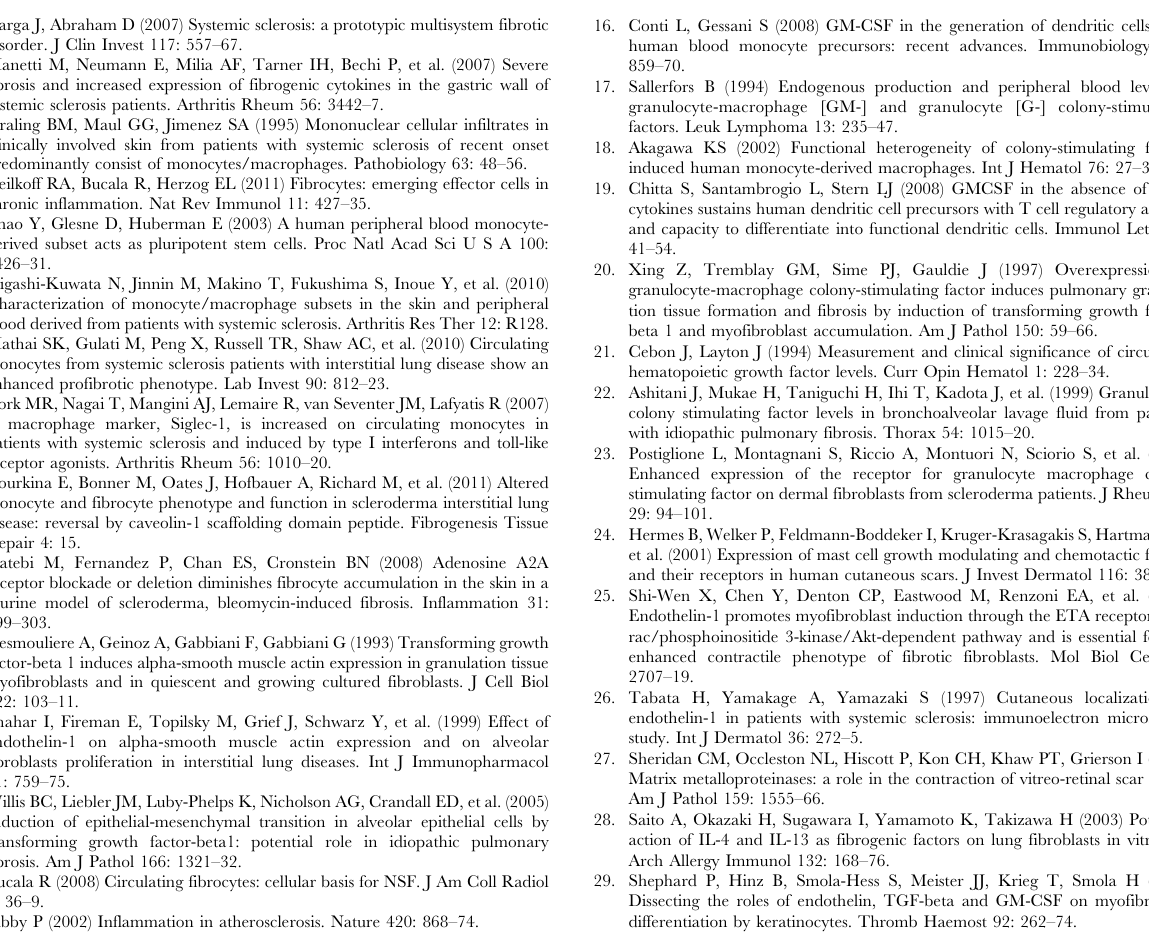
Figure S1 GM-CSF upregulates Vimentin in monocytes from SSc patients and healthy controls. Monocytes from healthy controls or SSc patients were cultured for 14 days with GM-CSF, IL-4 or ET-1. Vimentin levels were detected by Western blot analysis. GAPDH was used as loading